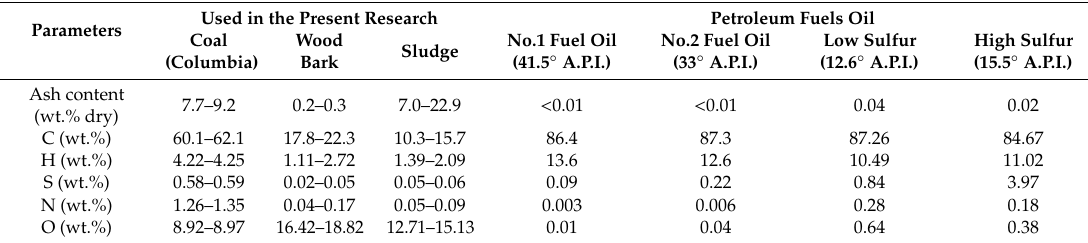
Table 1. Characteristics of combustion feedstock.